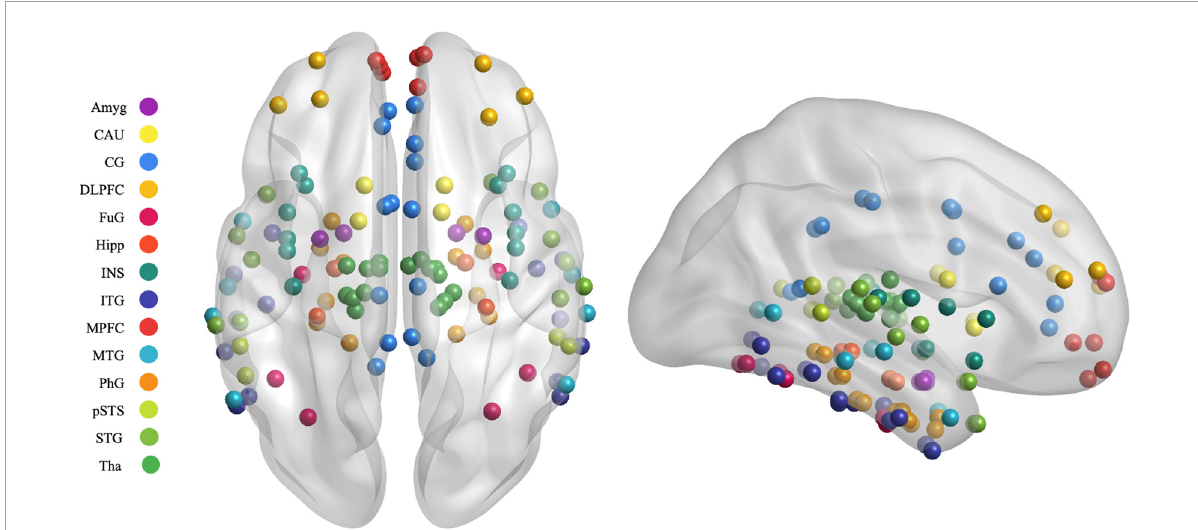
FIGURE3 Map illustrating brain of the regions of interest selected in the granger causality analysis. MPFC, medial prefrontal cortex; DLPFC, dorsolateral prefrontal cortex; SFG, superior frontal gyrus; MFG, middle frontal gyrus; OrG, orbital gyrus; STG, superior temporal gyrus; MTG, middle temporal gyrus; ITG, inferior temporal gyrus; FuG, fusiform gyrus; PhG, parahippocampal gyrus; pSTS, posterior superior temporal sulcus; INS, insular gyrus; CG, cingulate gyrus; Amyg, amygdala; Hipp, hippocampus; BG, basal ganglia; CAU, caudate, Tha, Thalamus.